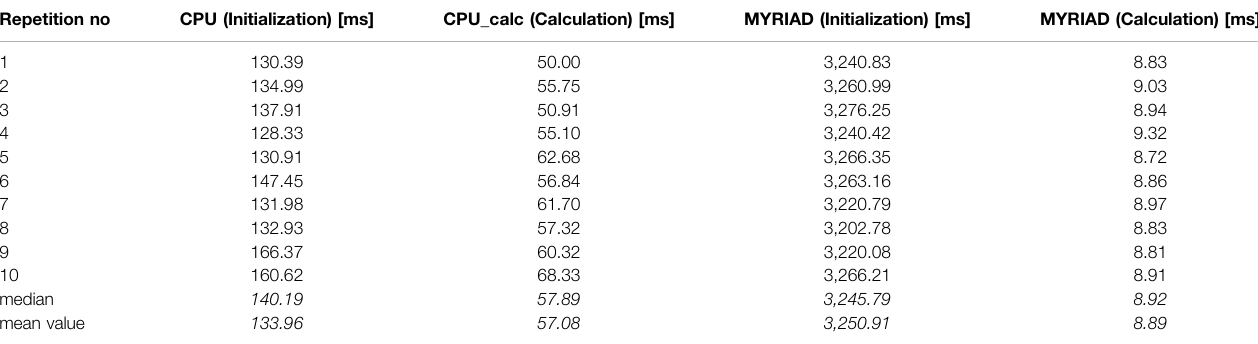
TABLE 1 | Execution times of the inference procedure on the CPU and MYRIAD platforms. The times for loading the data into the VM memory or the Neural Compute Stick accelerator memory (the column: “ initialization ” ) are also